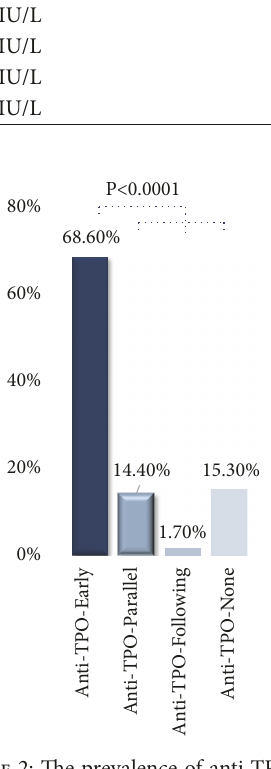
Figure 2: The prevalence of anti-TPO (anti-TPO-Early, blue) and anti-Tg (anti-Tg-Early, burgundy) prior to the onset of subclin- ical/overt hyperthyroidism compared to the combined control groups. Anti-TPO combined control group (blue) consists of anti- TPO-Parallel, anti-TPO-Following, and anti-TPO-None. Anti-Tg combined control group (burgundy) consists of anti-Tg-Parallel, anti-Tg-Following, and anti-Tg-None.